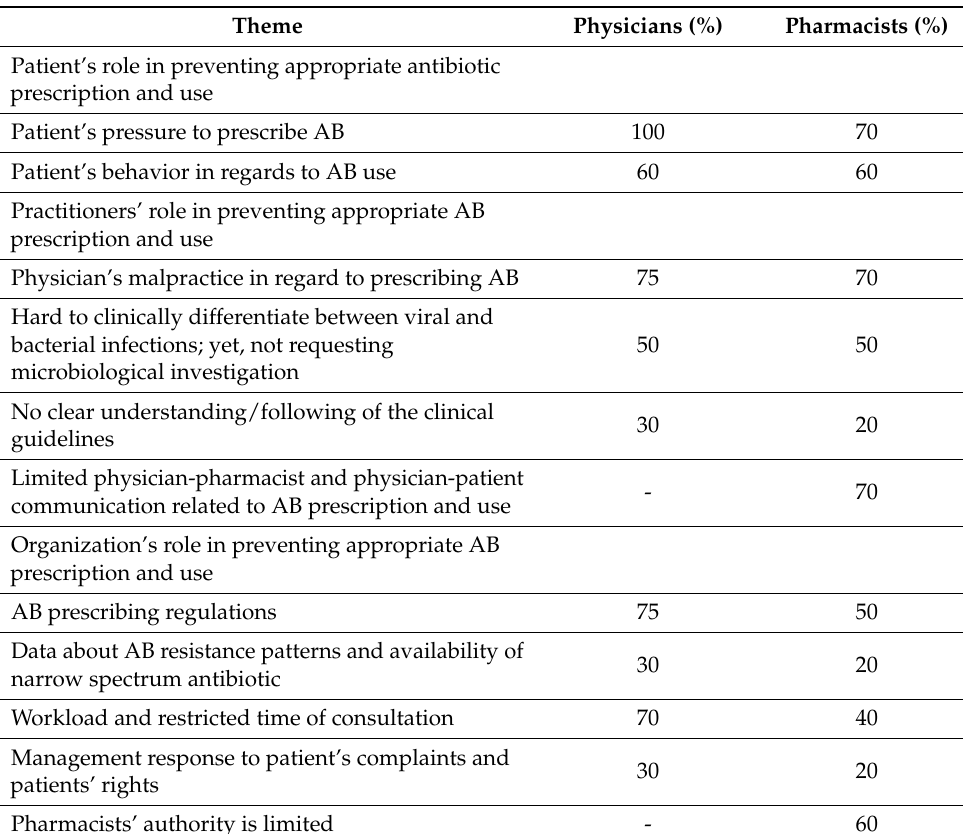
Table 1. Narrative Theme